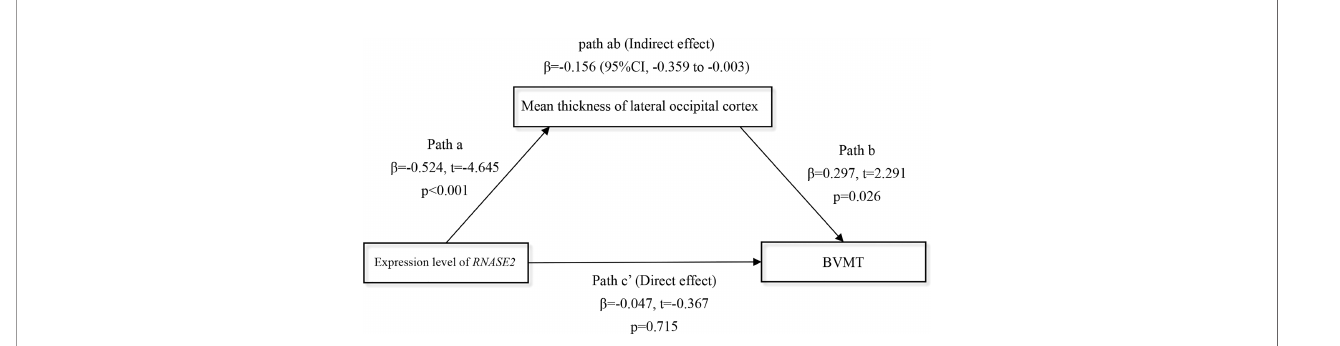
FIGURE 6 | Full mediation effect of the lateral occipital cortex between the gene RNASE2 and visual memory. Independent variable = RNASE2 expression level; Dependent variable = brief visual-spatial memory test (BVMT) score; Mediator = lateral occipital cortex. Age, sex, and education years were included